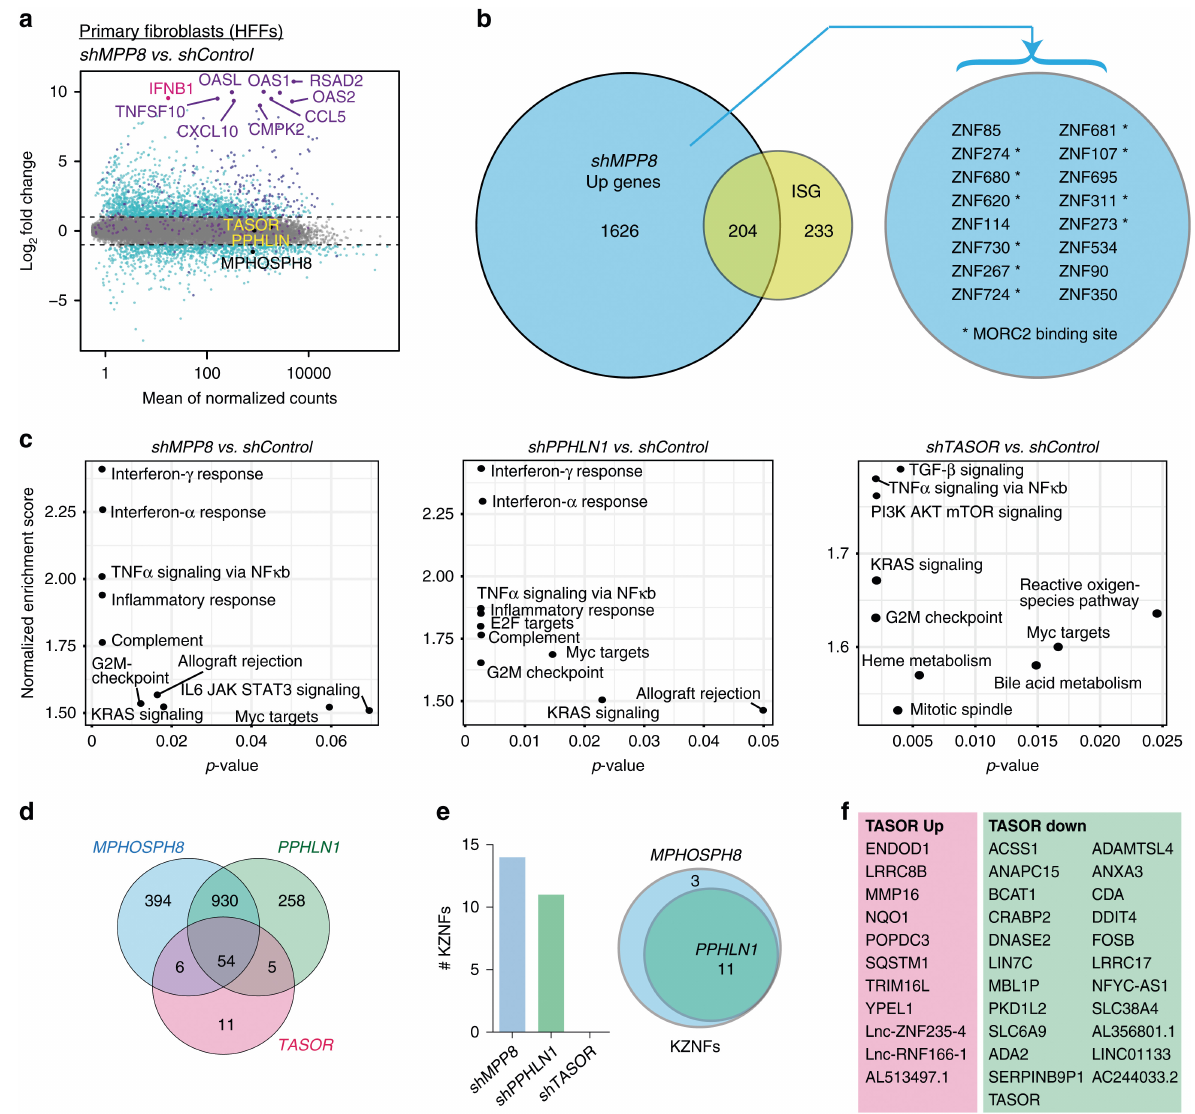
Fig. 2 The HUSH complex regulates genes involved in in fl ammation. Primary fi broblasts (HFFs) were treated with shRNA vectors, and RNA harvested 6 days later for total RNA-sequencing. N = 6 biologically independent experiments. a MA plot showing results of differential expression analysis, where signi fi cantly differentially expressed genes (log2 fold change > 1 and a p -adjusted value < 0.05 after Benjamini – Hochberg multiple testing correction of Wald test p -value of shMPP8/shControl) have been highlighted in dark cyan and ISGs are shown in purple. See dataset 1 in Source data for all exact p values. Example upregulated ISGs are labeled as well as HUSH components (of which MPHOSPH8/MPP8 is downregulated). b Venn diagram showing overlap of ISGs (list de fi ned in ref. 15 ) with genes upregulated in MPP8-depleted samples. Upregulated KZNFs are listed. See also Supplementary Fig. 2 for MORC2 binding data using public ChIP data 33 . c Total RNA-seq data were generated for samples depleted for each HUSH component vs. shControls ( n = 3 biologically independent experiments and data are represented as gene set enrichment analyses using fgsea, where nominal p-values were calculated for 1000 permutations and corrected for multiple-testing using the Benjamini – Hochberg method). d Venn diagram showing overlap of genes upregulated in each HUSH-depletion. e Comparison of number and overlap of KZNFs upregulated in HUSH-depleted cells. f Signi fi cantly differentially-expressed genes unique to TASOR-depleted samples are